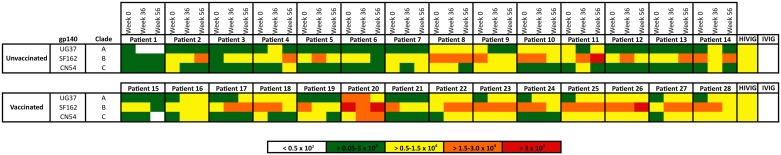
Microarray analysis of HIV-1 infected patient samples.The microarray chip was probed with unvaccinated (non-vaccine arm) and vaccinated (vaccine arm) patient plasma samples (week 0, week 36, and week 56) at a dilution factor of 1:100. HIV-1 specific gp140 envelope proteins were printed at a concentration of 0.01 mg/mL, which corresponds to 0.01 ng per spot. HIVIG and IVIG were included as a positive control and negative control, respectively. Antibody signal intensities were color-coded using green (>0.05–0.5 x 103) for weak, yellow (>0.5–1.5 x 104) for intermediate, orange (>1.5–3.0 x 104) and red (>3.0 x 104) for strong interaction. Non-specific binding was indicated as white (<0.5 x 102) boxes. Raw data is indicated in S3 Fig.